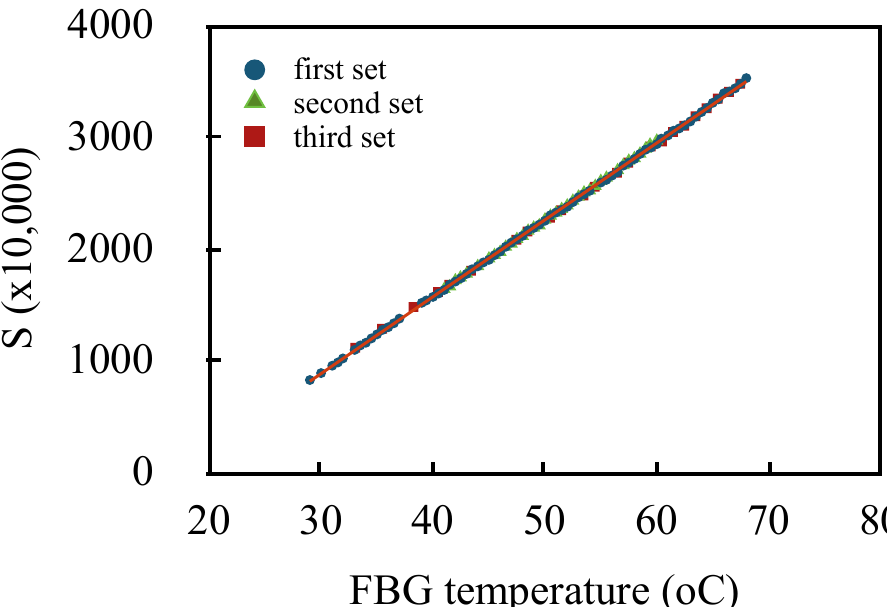
Figure 6. Signal S as a function of the FBG sensor temperature for three measurement